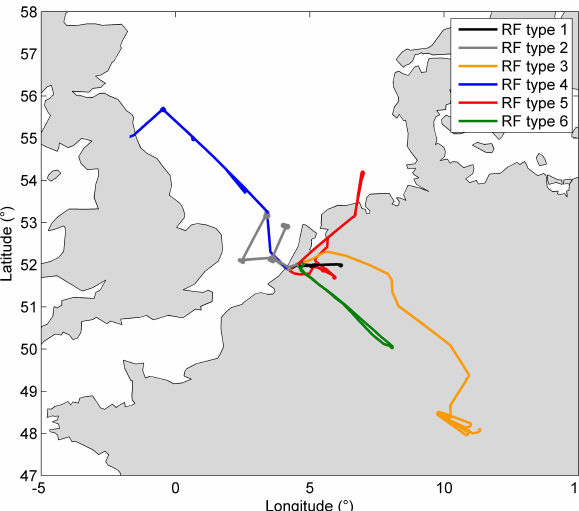
Fig. 1. Different types of research flight (RF) plans performed dur- ing the EUCAARI intensive observation campaign in May